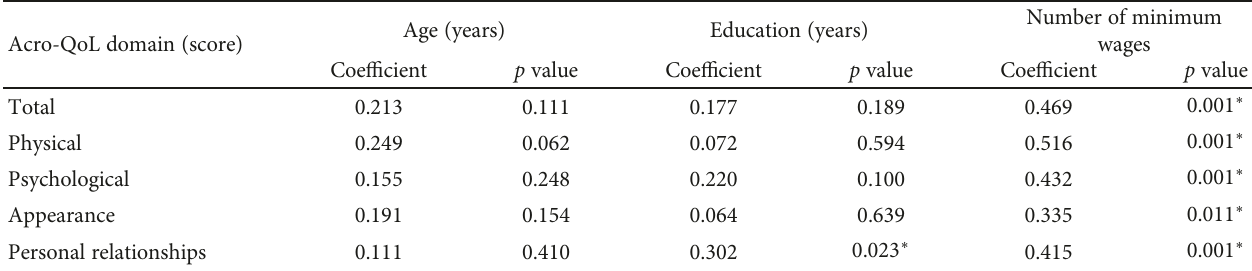
Table 5: Correlation between the Acro-QoL domain scores and the socioeconomic status and disease diagnosis variables, São Luís, state of Maranhão, Brazil, 2015. Acro-QoL domain (score)